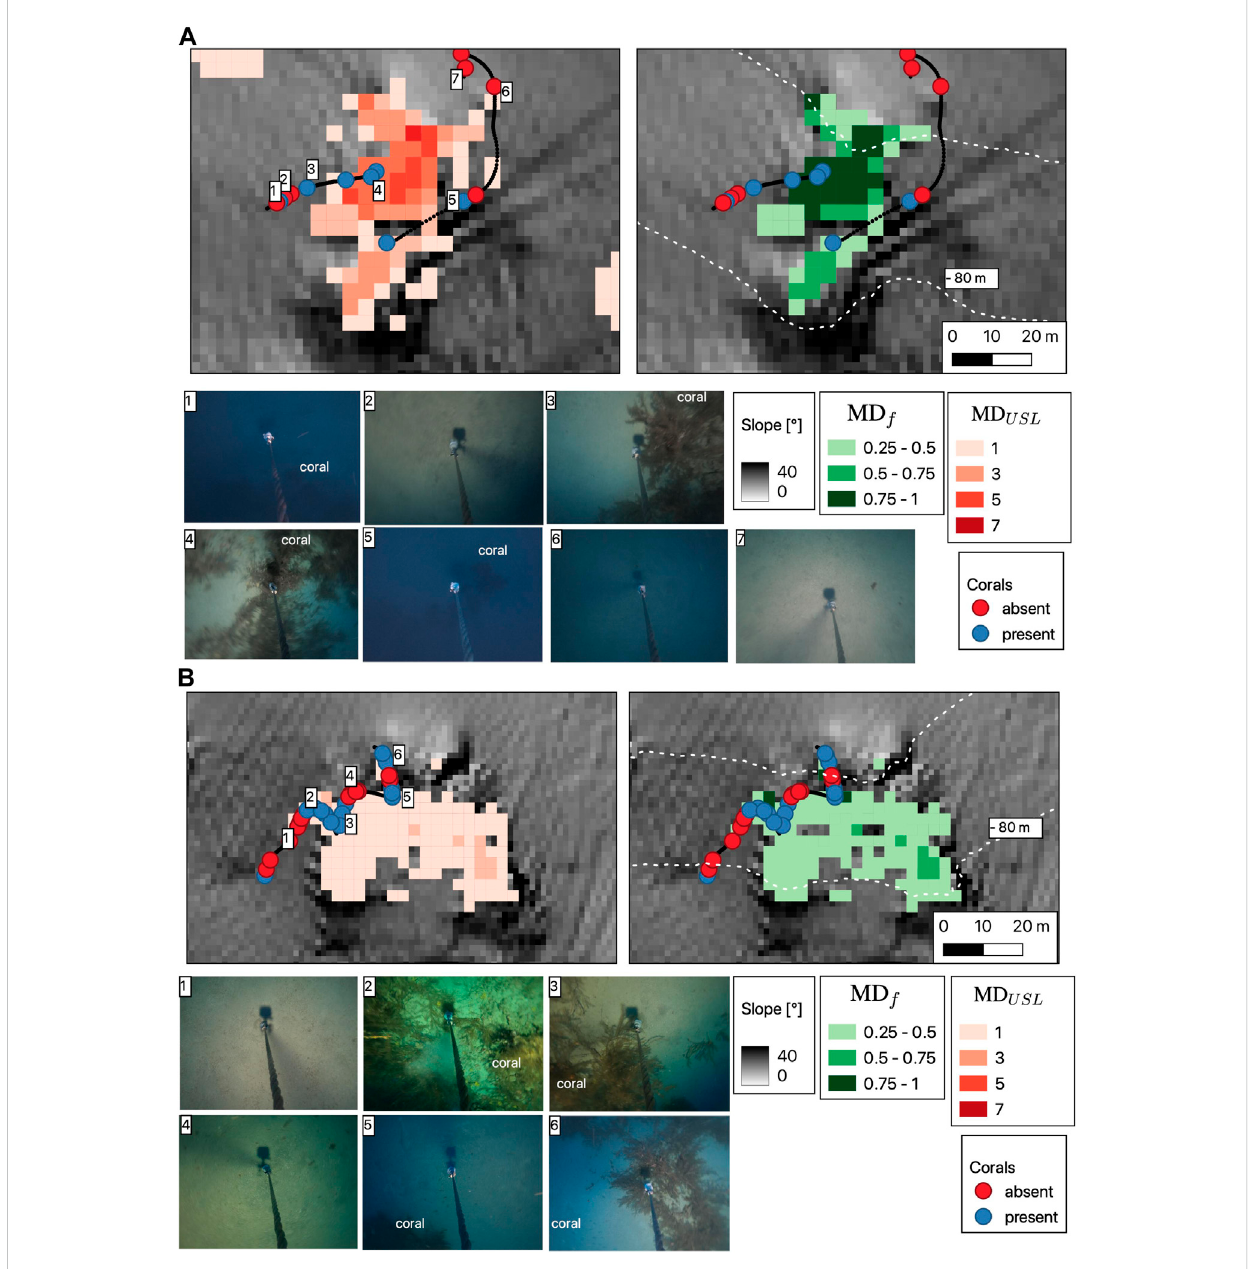
FIGURE 5 Comparison of ground truthing information with the grids of MD USL and MD f . (A) Ridge A. (B) Ridge B. Refer to Figure 2 for location.